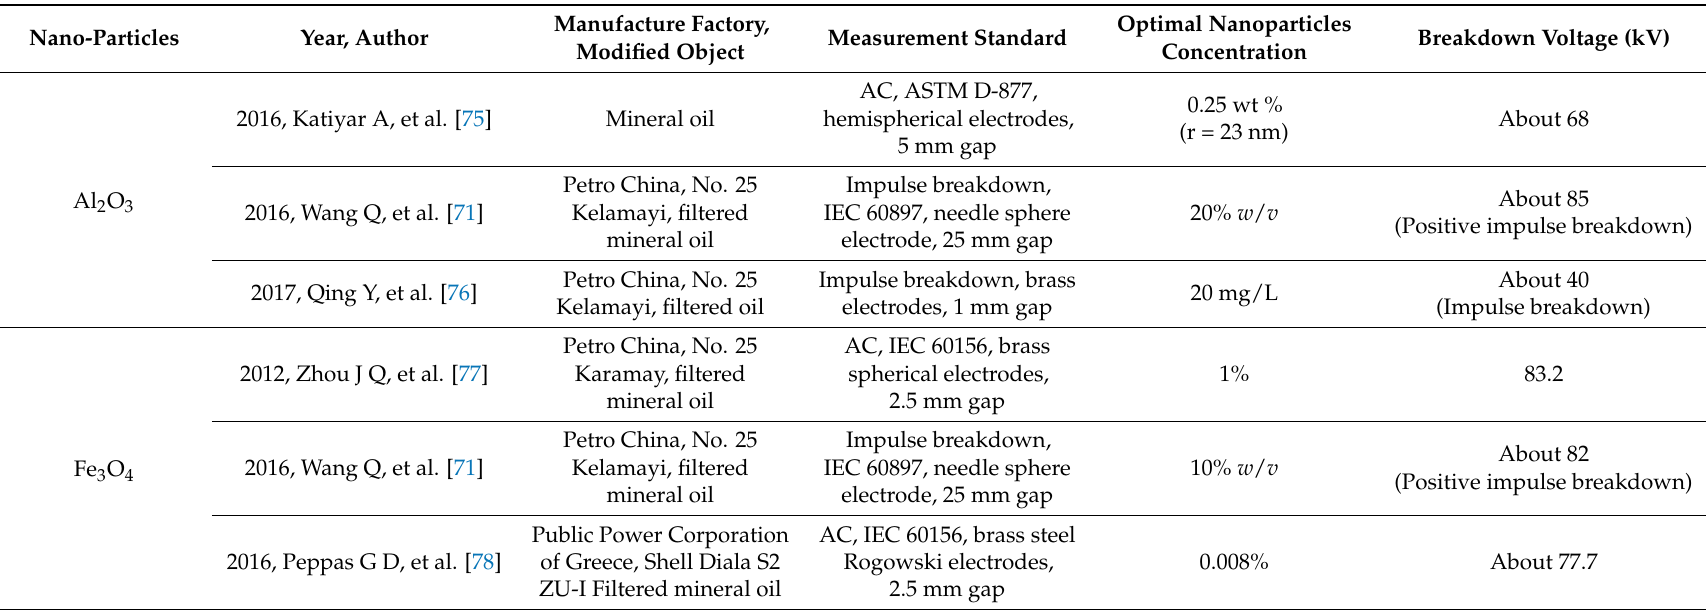
Table 3. Breakdown voltages of nano-Al 2 O 3 -modified and nano-Fe 3 O 4 -modified mineral insulating